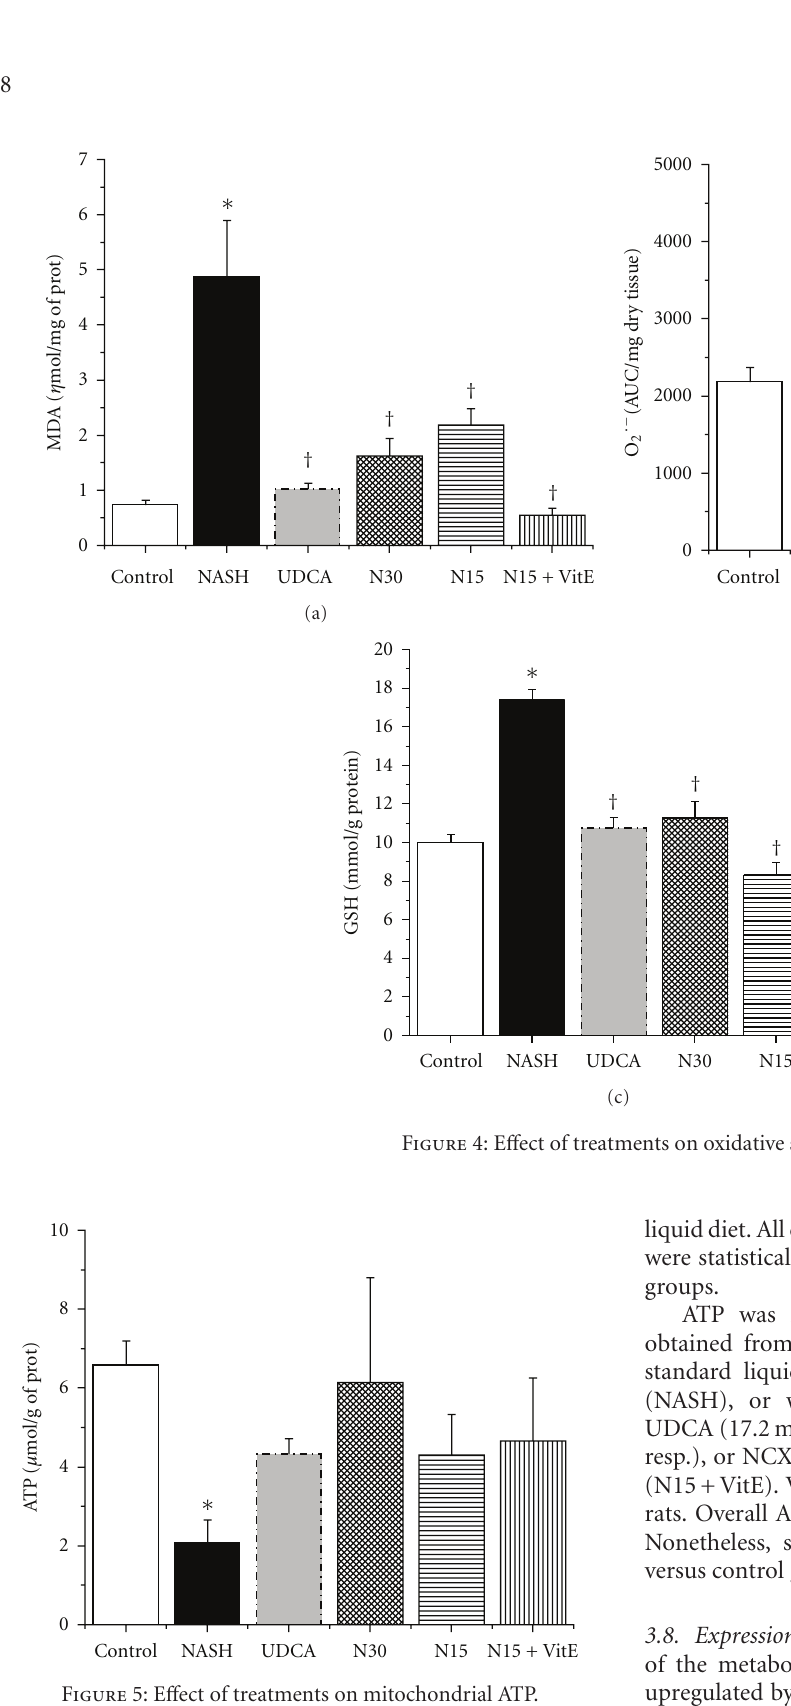
than in the control group ( P < 0 . 05). This is indicative of cellular energetic imbalance caused by a 12-week